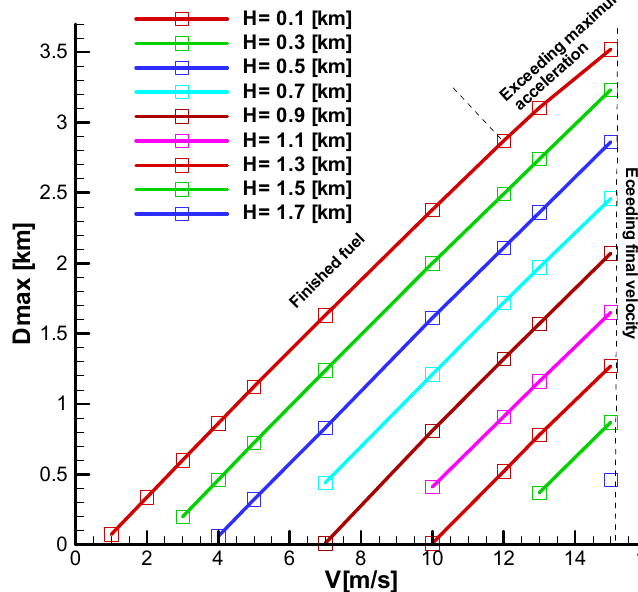
Figure 27. Maximum distance for horizontal evolution—second scenario.